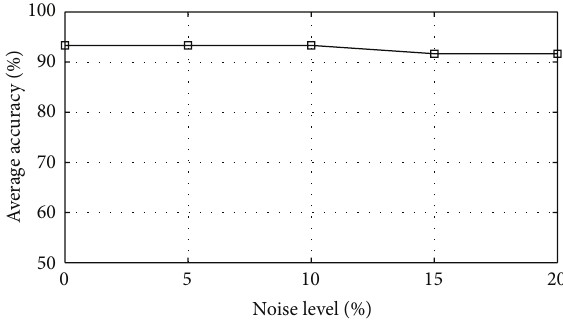
Figure 9: The identification results when the approximate modal responses are added with noises with different levels.